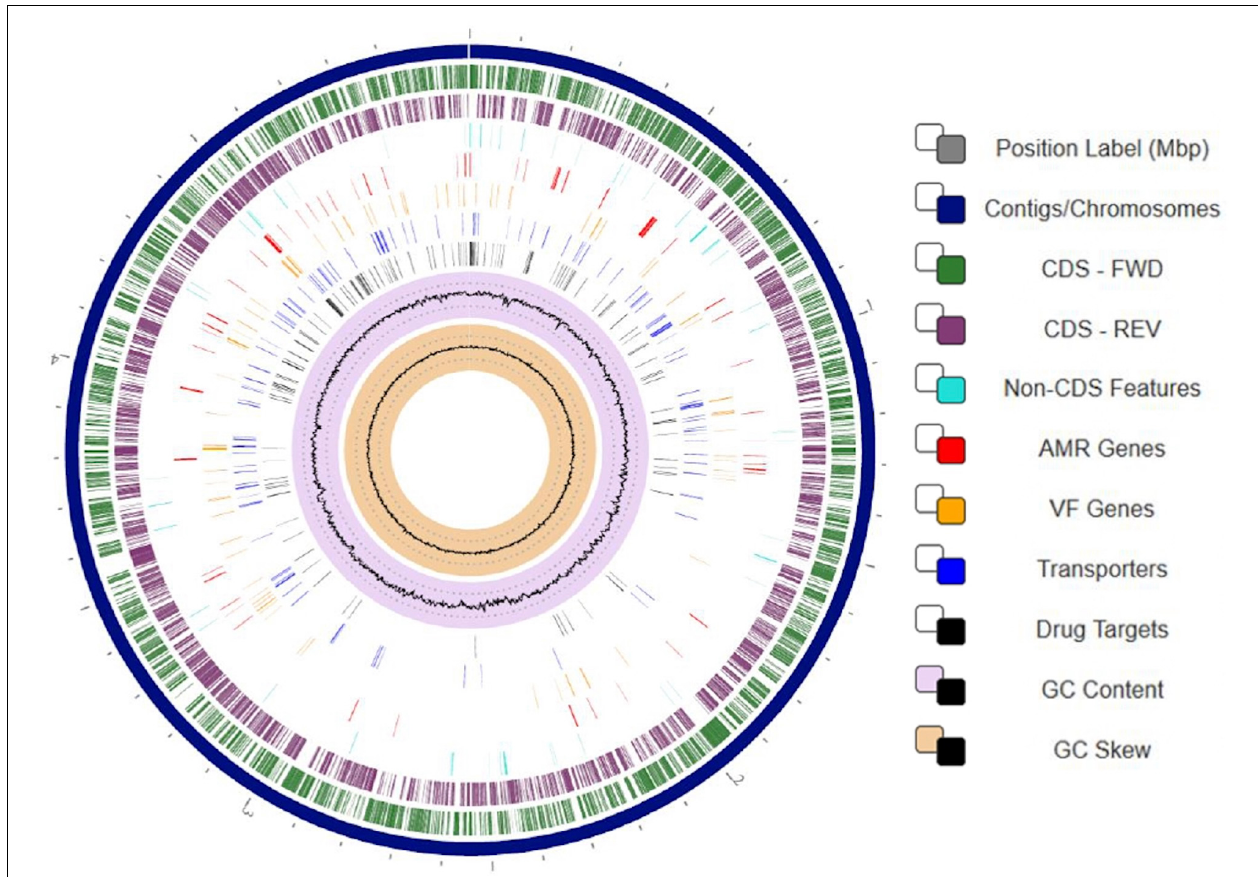
FIGURE 6 | Circular visualization of the Rouxiella badensis strain SER3 genome. Numbers represent megabases (Mbp). From outside to the center: 47 contigs were assembled to form a scaffold representing the chromosome (navy blue track). Genes on forward strand (green), genes on reverse strand (purple), non-CDS features (turquoise), resistance genes (red), virulence factor genes (orange), transporters (blue), drug targets (black), GC content (lilac and black), and GC skew (khaki and black). To display the circular viewer, we used genome annotation service from PATRIC (RAST tool